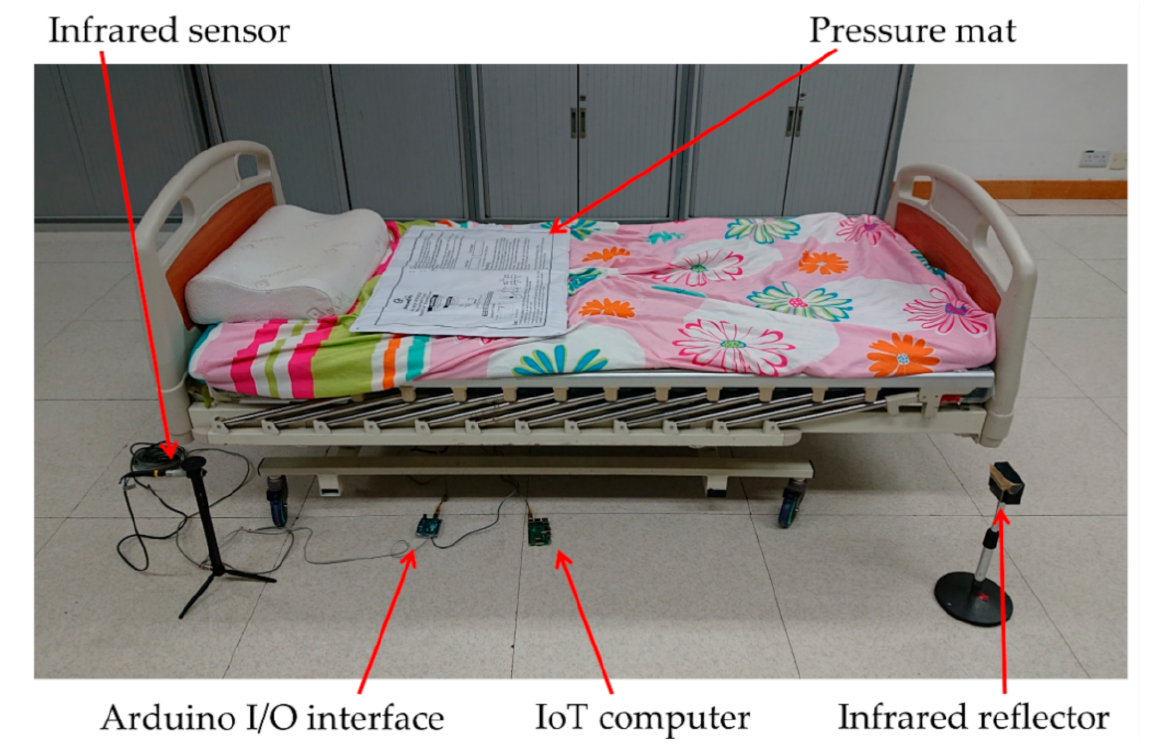
Figure 4. The hardware configuration of the conventional bed exiting detection